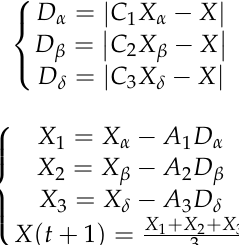
of α , β and δ . In order to provide wolves with a good ability to identify potential prey, the fitness of grey wolves is updated during each iteration calculation, and the three wolves with the best fitness are selected as α , β and δ respectively. According to the position information of α , β and δ , the position information of the remaining wolves is updated at the next moment. The process expressions are shown in Equations (16) and (17).